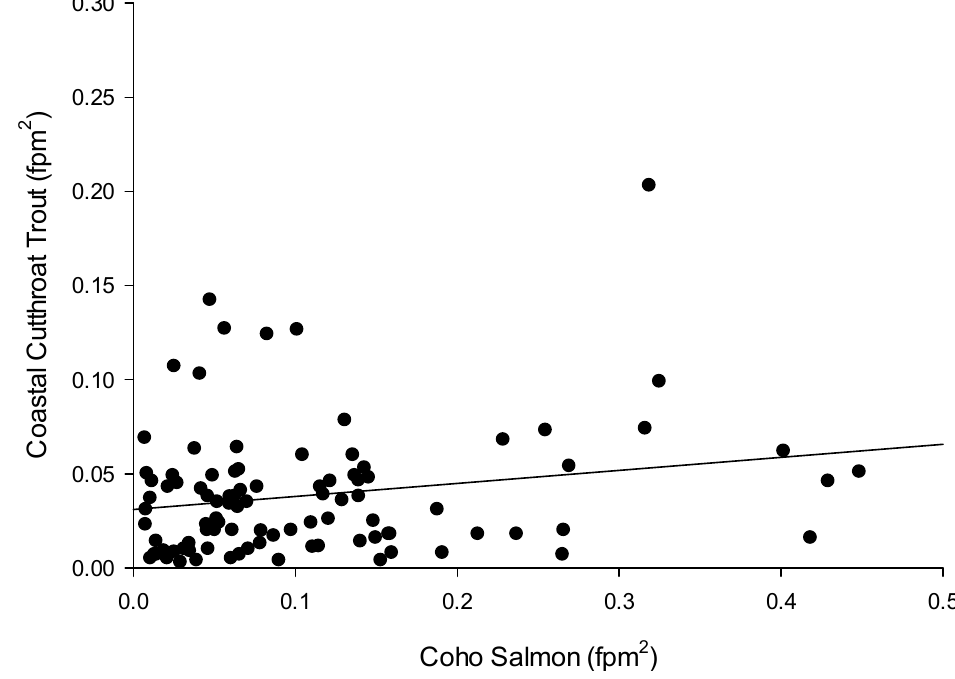
Figure 3. The relationship between fish per meter squared of coastal cutthroat trout and coho salmon when both species were present in streams with less than 9% stream gradient. Sites without coastal cutthroat trout or coho salmon were removed for this analysis. Regression line is presented for visual aid only. Table 3. Model selection of factors influencing coho salmon densities in watersheds in SNF and the OESF in watersheds with less than 9% steam gradients. Models within 2 ∆ AIC units of the top-ranked model have substantial support and are in bold. CTT = coastal cutthroat trout